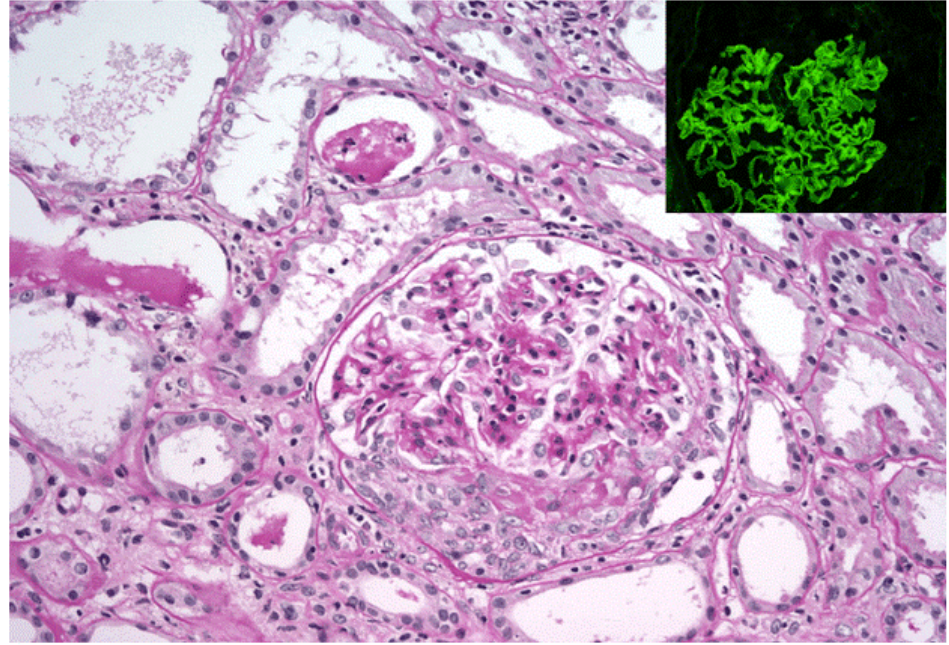
FIGURE 2. Renal biopsy . Necrotizing and crescentic lesions with marked destruction of the glomerular tuft with fibrin deposition were seen in 15/19 glomeruli. Mild expansion of the interstitium was also present with sparse mononuclear inflammatory infiltrates. Some of the tubules were dilated with loss of nuclei, consistent with a degree of acute tubular necrosis. Direct immunofluorescence of nonsclerotic glomeruli showed bright linear staining for IgG and light chains (inset). Half of them also showed 3+ patchy staining for C3. 1-2 + patchy mesangial staining for IgM and IgA was also seen. There was no evidence of C4 or C1q deposition. (PAS stain; original magnification 